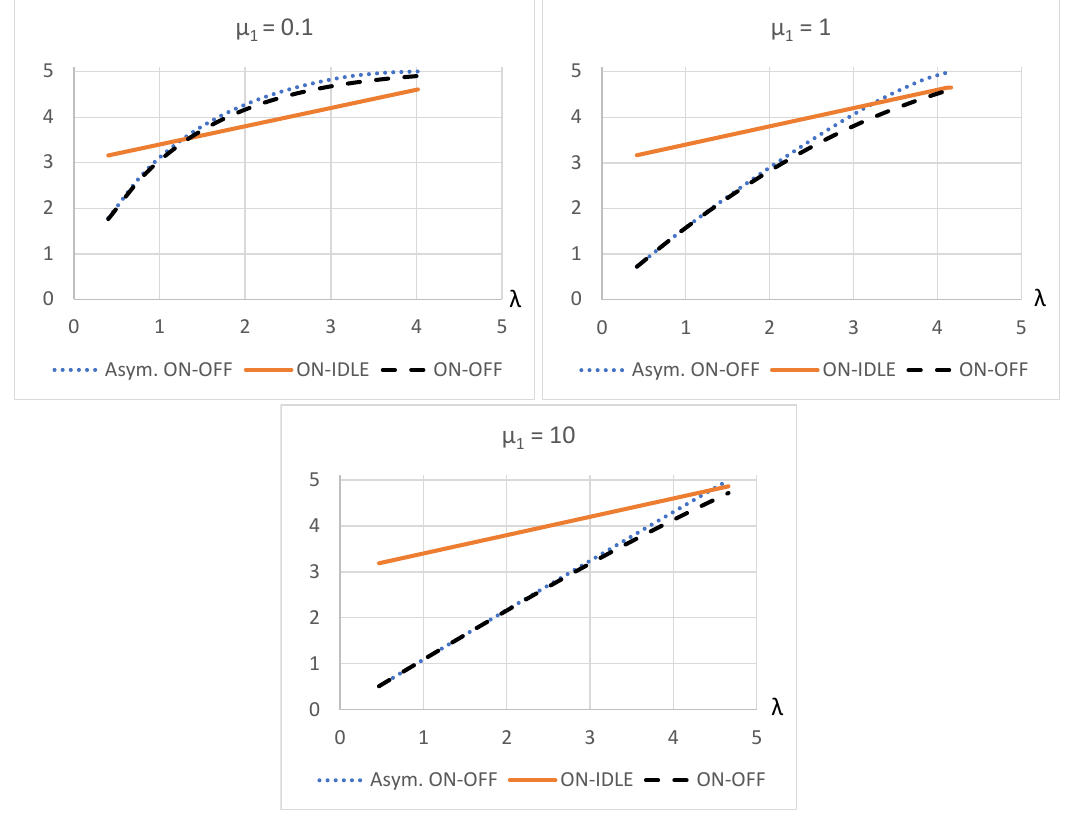
Figure 3. Power consumption against the arrival rate λ